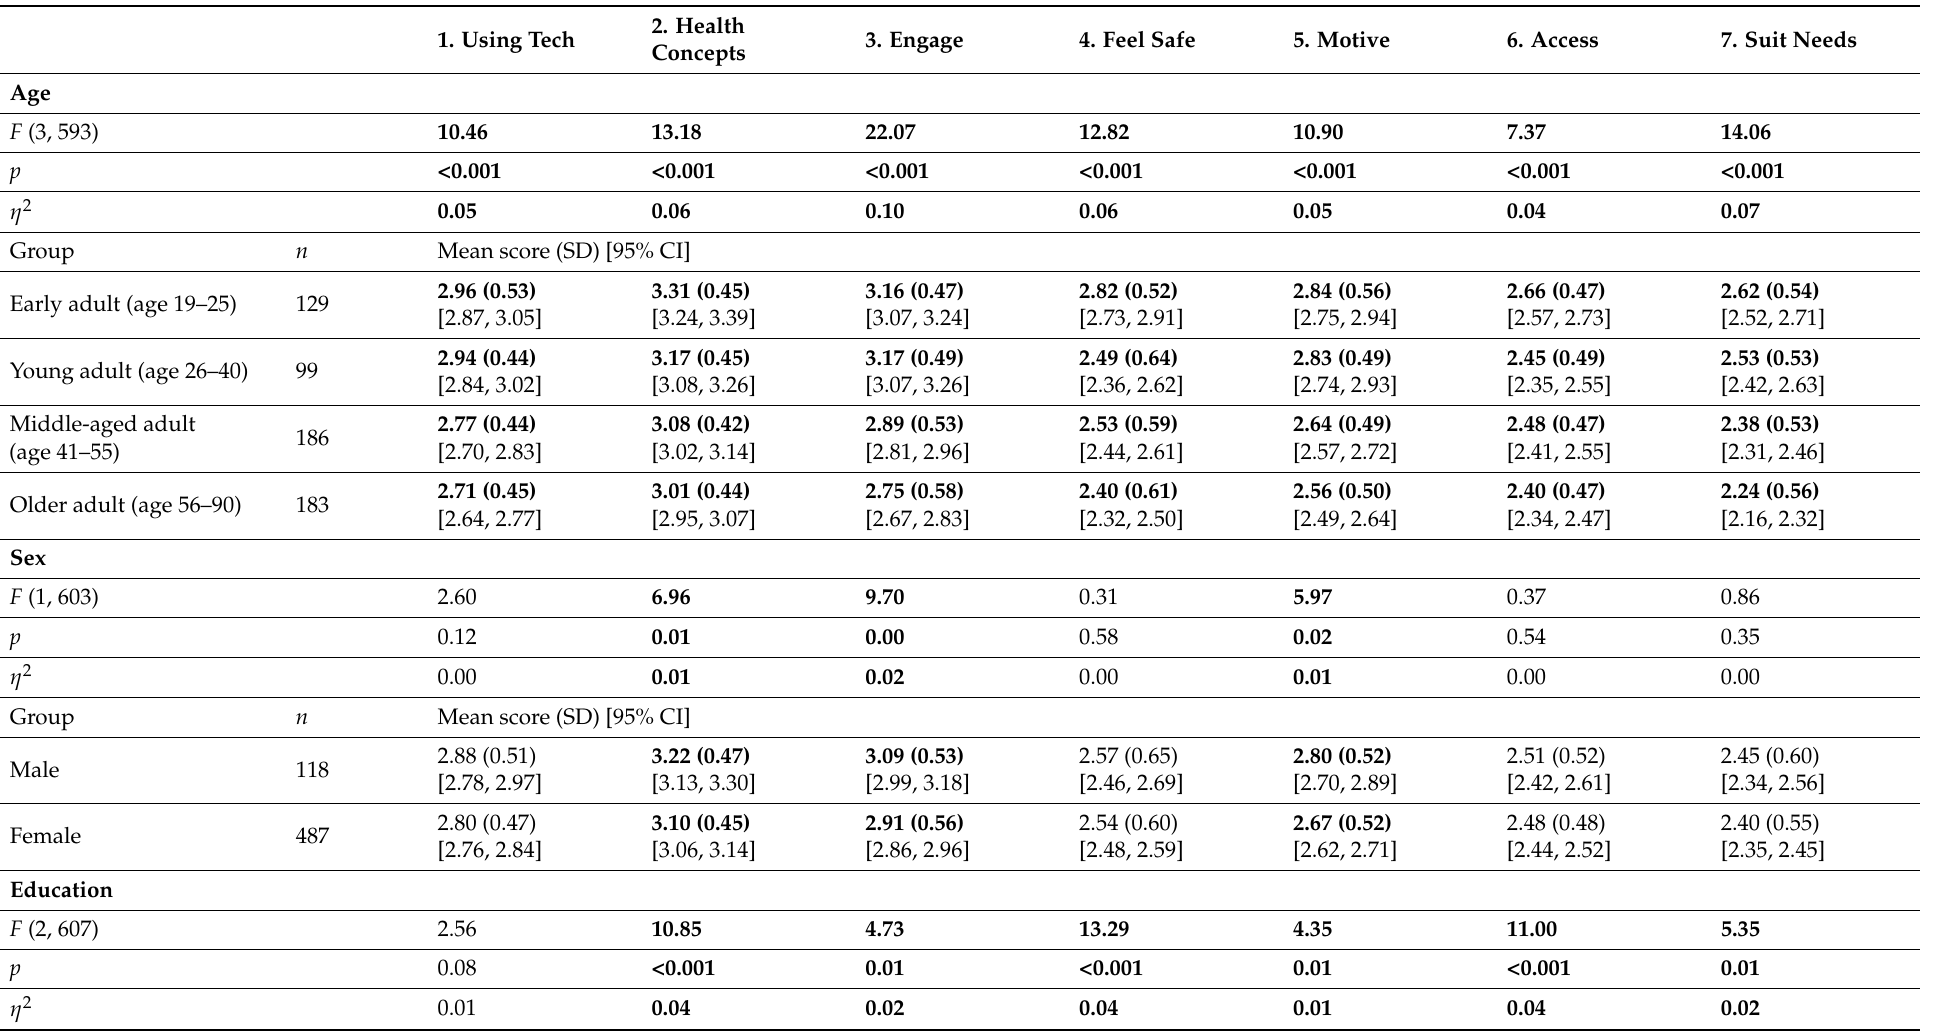
Table 4. Relationship between sociodemographic characteristics and individual eHealth Literacy Questionnaire (eHLQ)